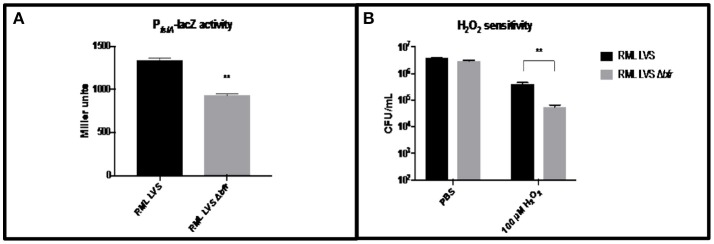
Iron related phenotypes of RML LVS Δbfr. (A) PfslA-lacZ reporter activity is decreased in the RML LVS relative to wild type. Welch's t-test was used to test for significance. Shown is a representative of five replicates. (B) The RML LVS Δbfr is more sensitive to H2O2 killing than the wild type. A two-way ANOVA with Sidak's multiple comparisons test was used to test for significance. Significance was set at p < 0.05. **Indicates a significant difference between the samples indicated. Shown is a representative of four replicates.